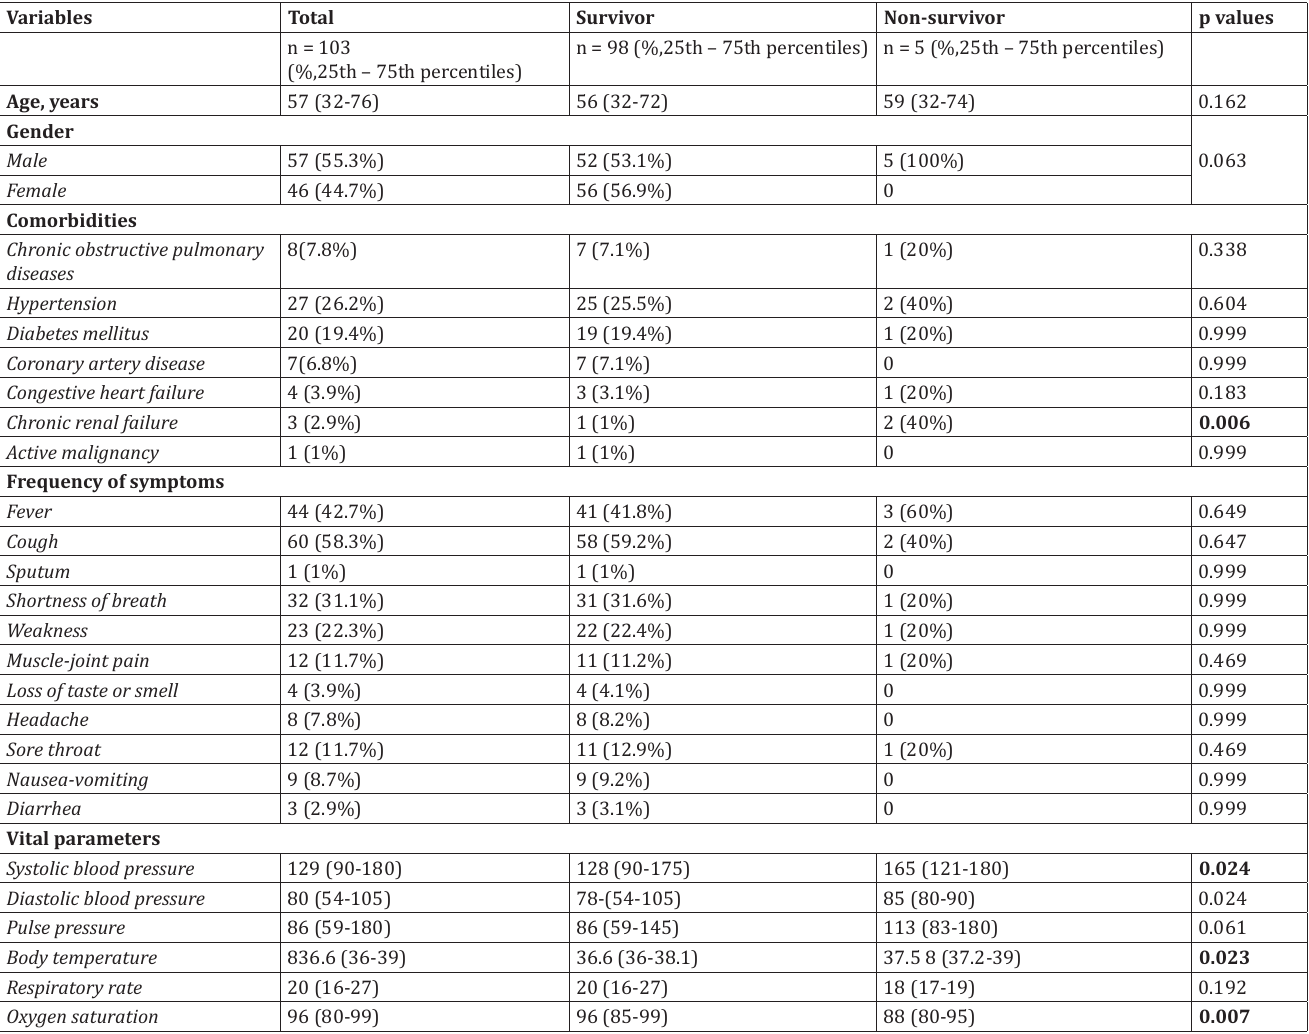
Baseline characteristics of the enrolled patients and comparison of these characteristics between the survivor and non-survivor groups